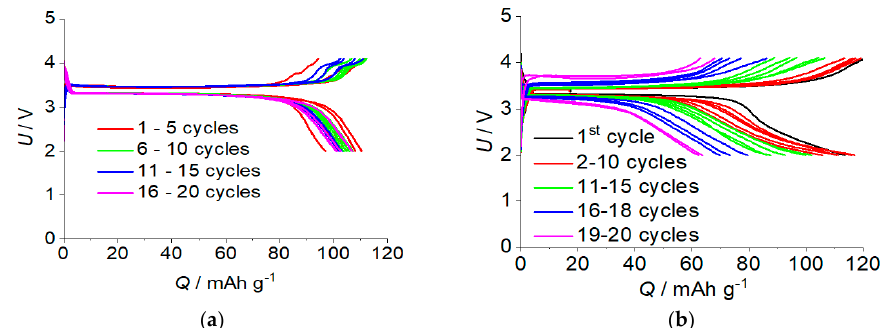
Figure 4. Charge–discharge curves of coin cells with polymer electrolytes based on Nafion 117, intercalated by EC-PC ( a ) and EC-PC-DMA-THF ( b ) mixtures. Current density of 10 mA·g − 1.